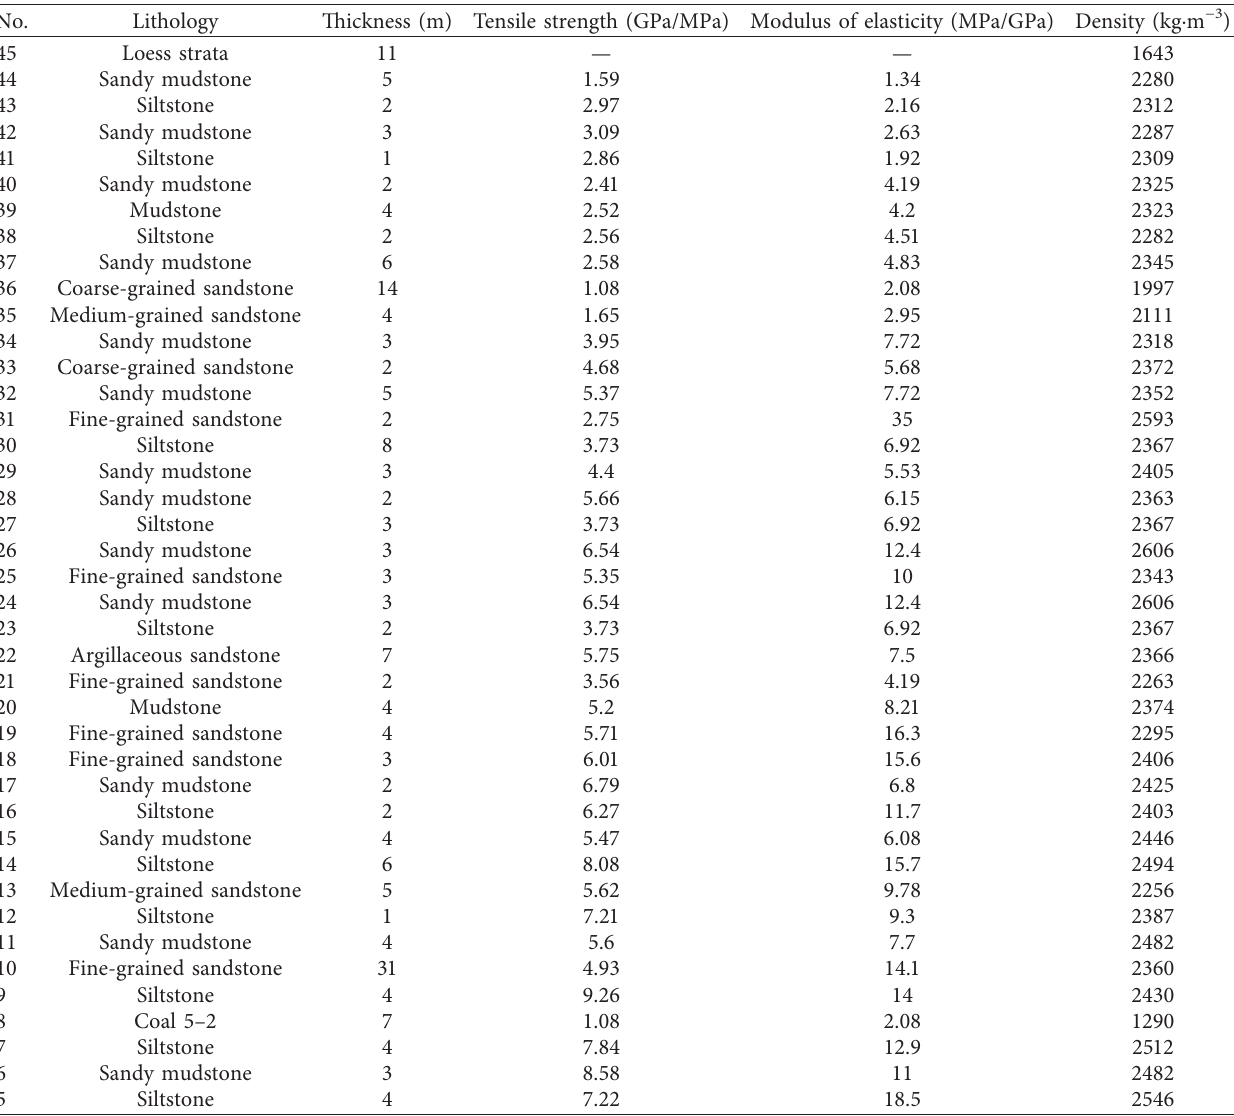
Table 3: Rock mechanics parameters in numerical